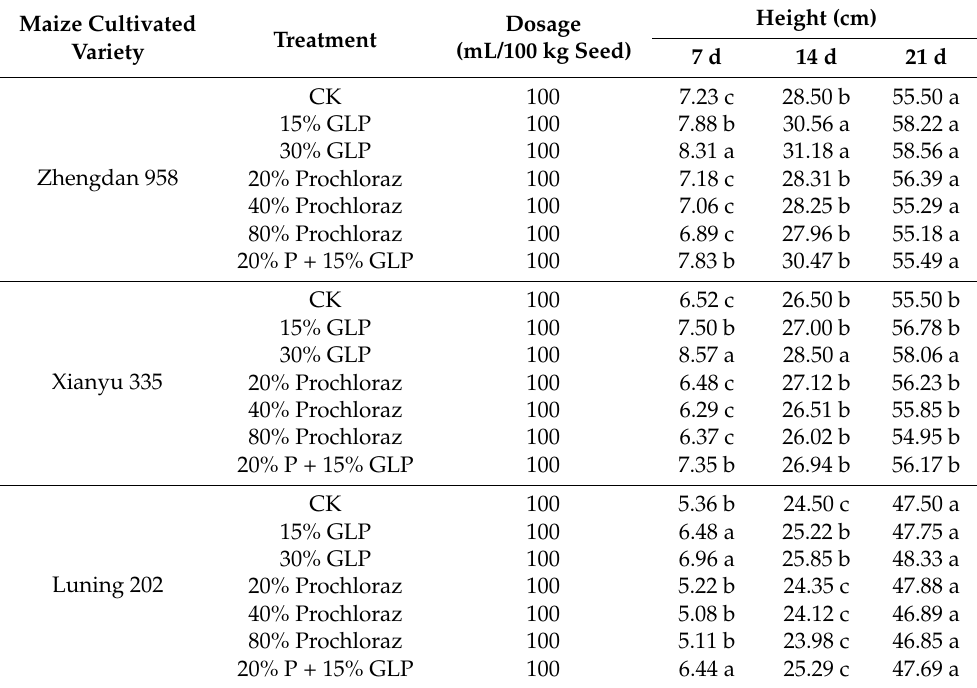
Table 8. Effects of seed dressing on the growth of maize